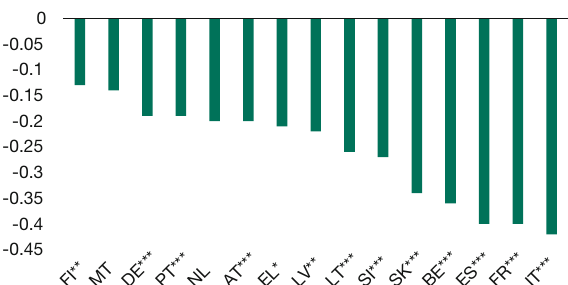
Figure 8 Sensitivity to a change in lockdown measures and share of contact-intensive sectors in value